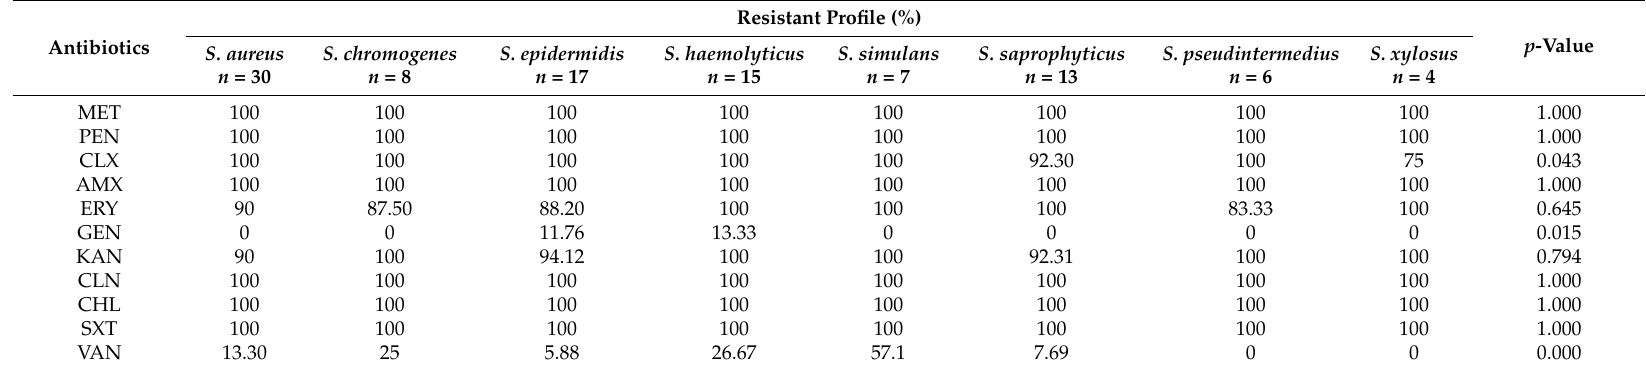
Table 2. Antimicrobial susceptibility profile of staphylococcal